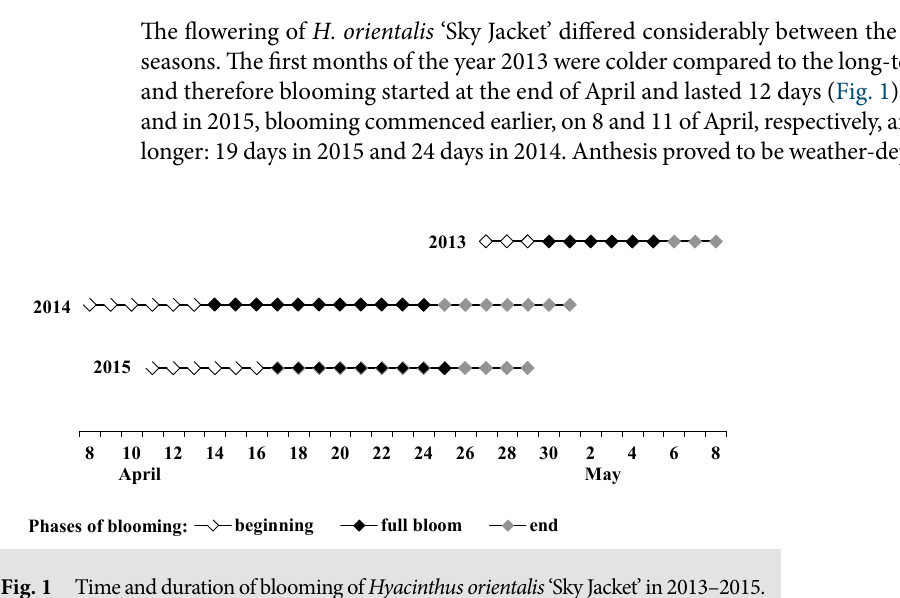
Fig. 1 Time and duration of blooming of Hyacinthus orientalis ‘Sky Jacket’ in